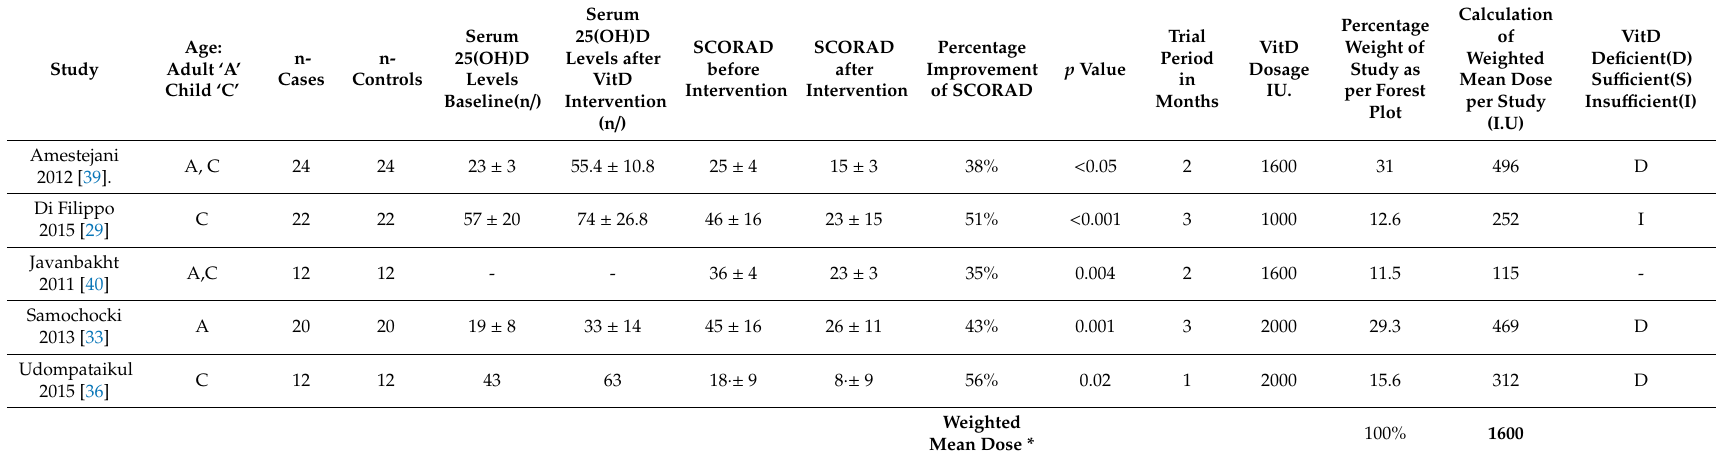
Table 4. Data of interventional studies included in the